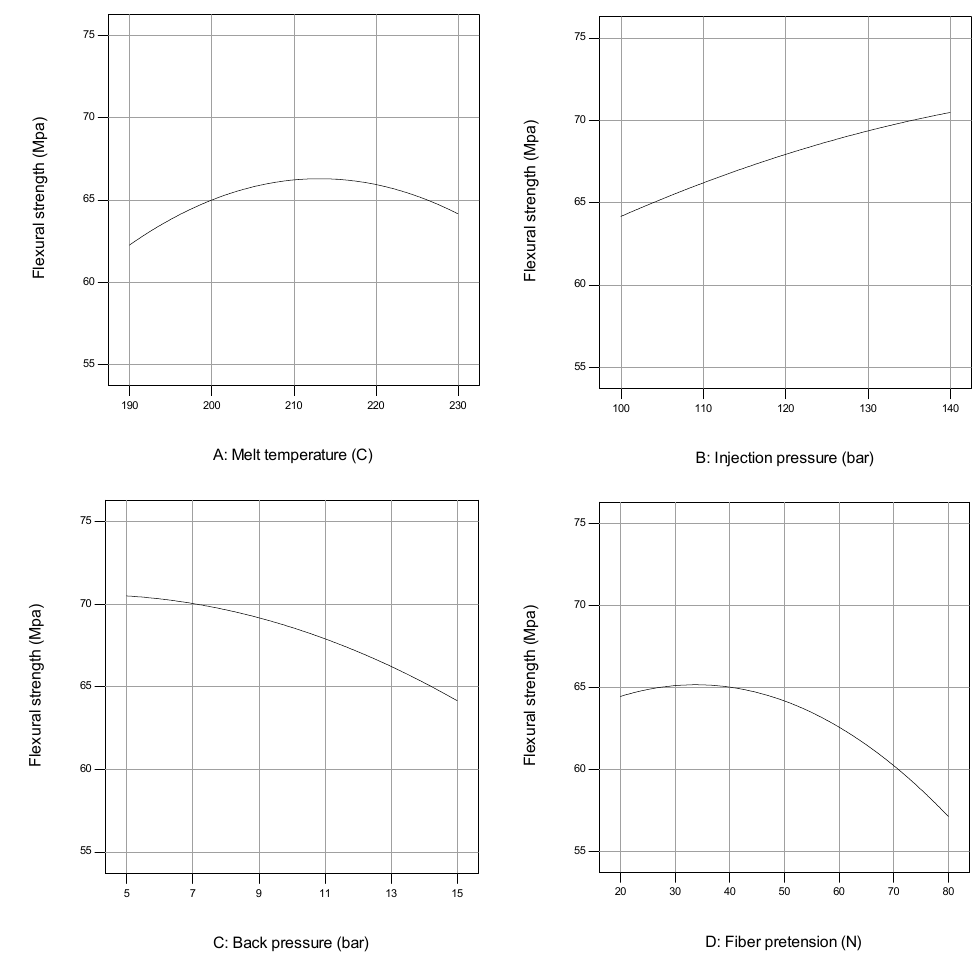
Figure 13. Influence of individual factor on the flexural strength: ( A ) melt temperature; ( B ) injection pressure; ( C ) backpressure; and ( D ) fiber pretension.